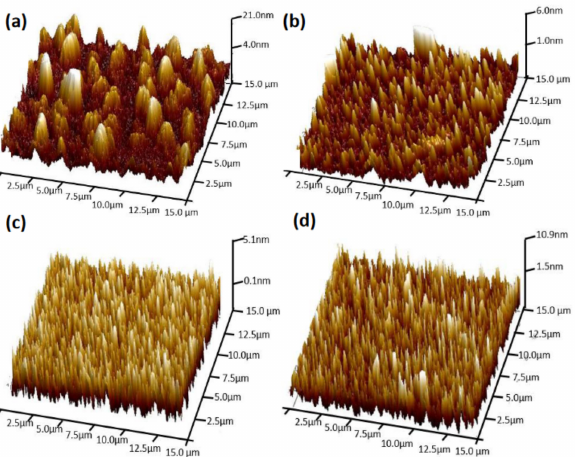
Figure 5. Three-dimensional representation (15 × 15 µ m 2 ) of the surface morphology of the ( a ) TiN-